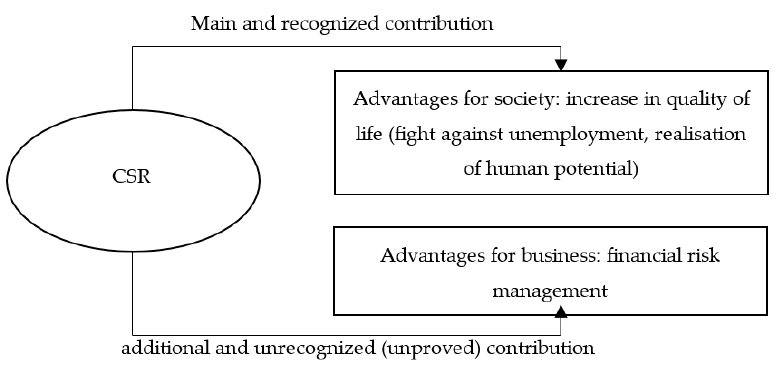
Figure 1. The theory of CSR. Source: authors.